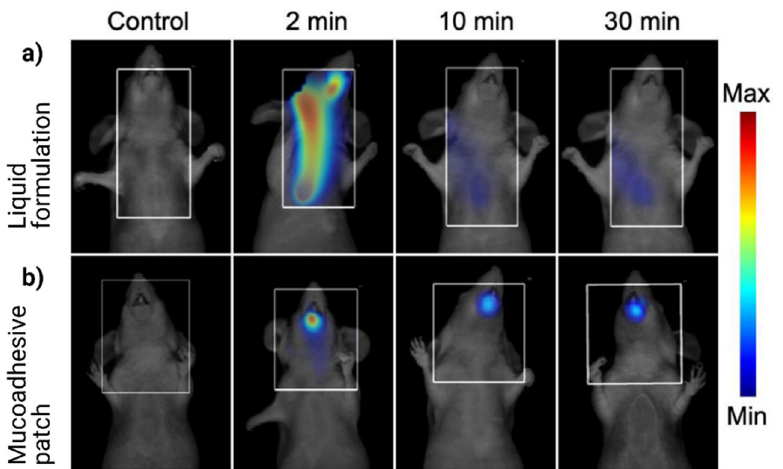
Figure 10. Fate of ovalbumin protein in conventional and mucoadhesive formulation: ( a ) rats administered with a liquid formulation of ovalbumin protein, ( b ) rats administered with ovalbumin mucoadhesive patch (Reprinted with permission from Paris et al. 2021 [102]).